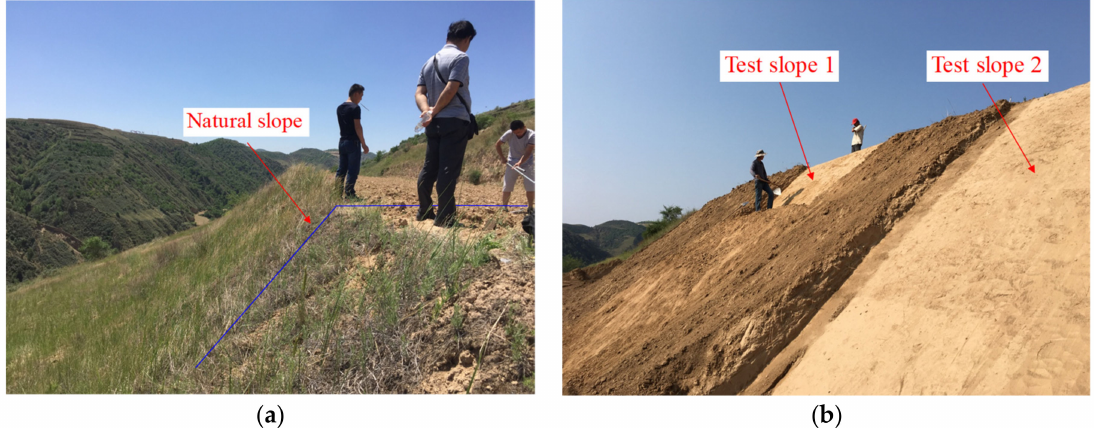
Figure 2. Test slope: ( a ) natural slope, ( b ) test slope after